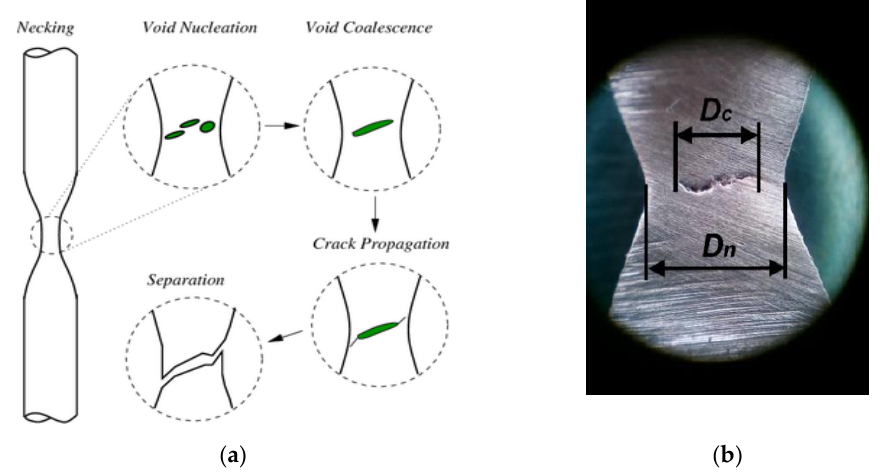
Figure 1. Scheme of damage formation ( a ) and internal crack in the sample neck ( b )